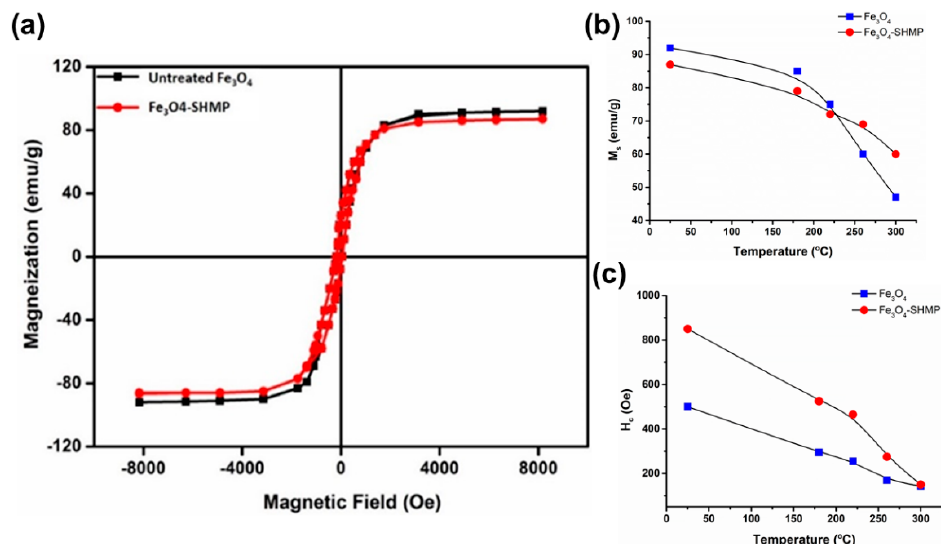
Figure 11. ( a ) Room temperature (25 ◦ C) M-H (magnetization-hysteresis) loop of bare Fe 3 O 4 and SHMP-treated Fe 3 O 4 , ( b ) plot of M s , and ( c ) H c values for bare and SHMP-treated Fe 3 O 4 at different